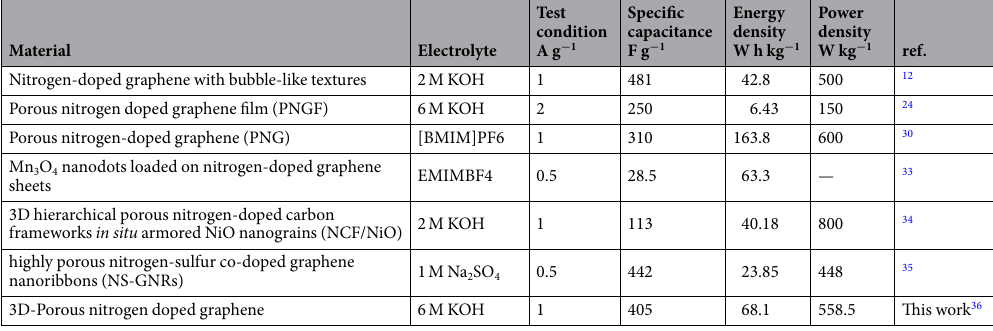
Table 1. Electrochemical performance of various supercapacitors fabricated based on nitrogen doped graphene